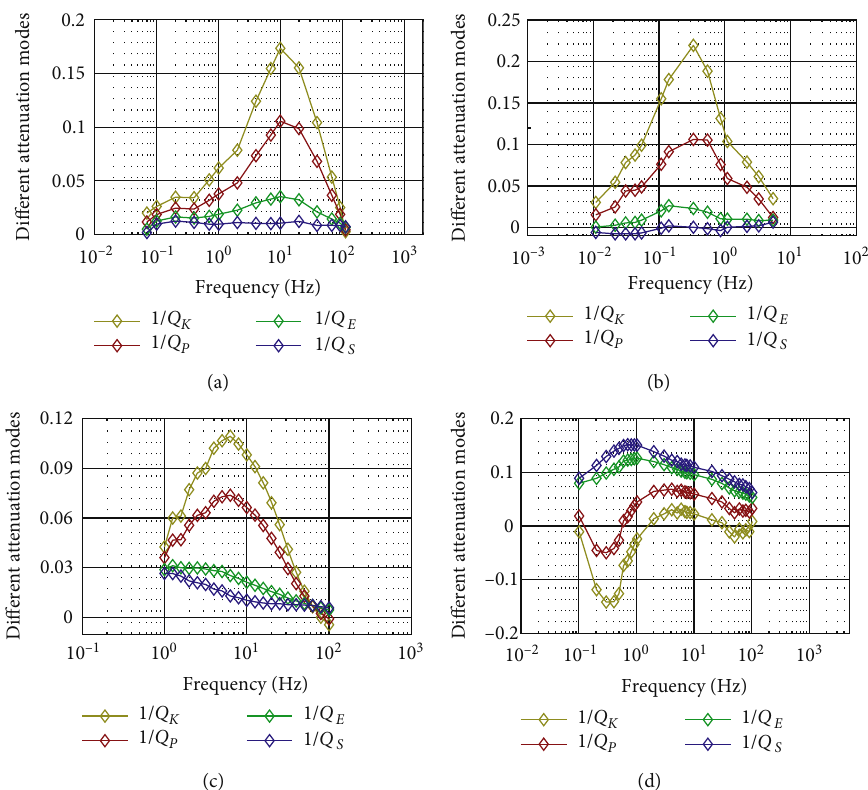
Figure 8: The relationship of di ff erent attenuation modes at di ff erent saturation state (from Sun et al. [18]; Borgomano et al. [15]; Sun et al. [17]; and Pimienta et al. [20],,